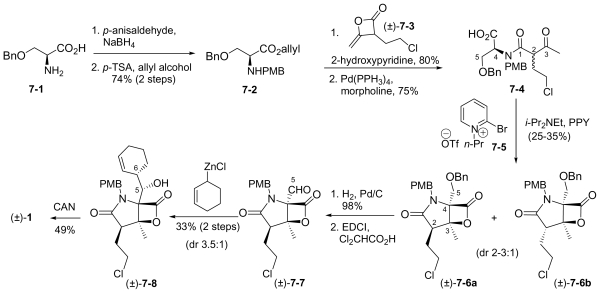
Romo and coworkers’ racemic synthesis of (±)-1 [45].